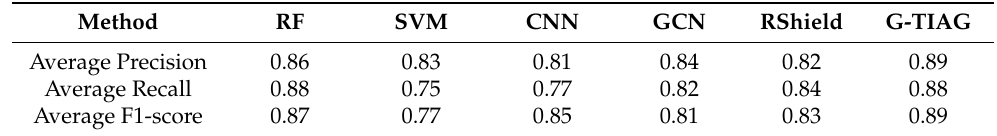
Table 9. Performance of five